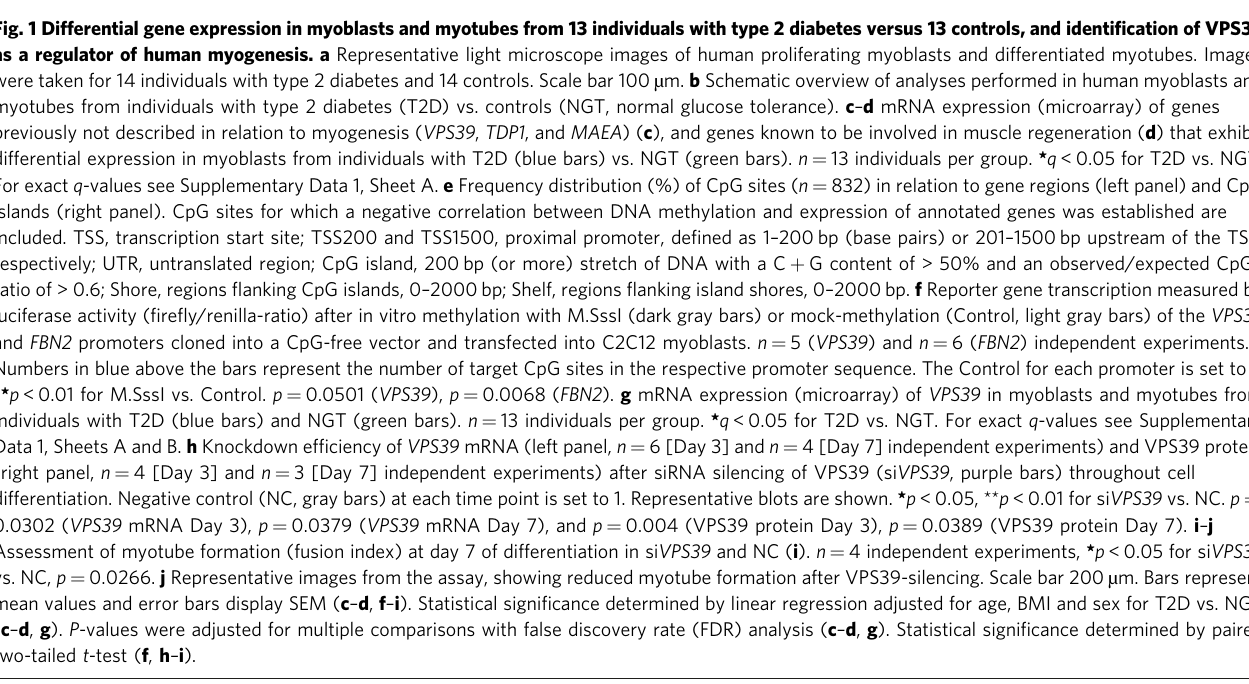
Fig. 1 Differential gene expression in myoblasts and myotubes from 13 individuals with type 2 diabetes versus 13 controls, and identi fi cation of VPS39 as a regulator of human myogenesis. a Representative light microscope images of human proliferating myoblasts and differentiated myotubes. Images were taken for 14 individuals with type 2 diabetes and 14 controls. Scale bar 100 µ m. b Schematic overview of analyses performed in human myoblasts and myotubes from individuals with type 2 diabetes (T2D) vs. controls (NGT, normal glucose tolerance). c – d mRNA expression (microarray) of genes previously not described in relation to myogenesis ( VPS39 , TDP1 , and MAEA ) ( c ), and genes known to be involved in muscle regeneration ( d ) that exhibit differential expression in myoblasts from individuals with T2D (blue bars) vs. NGT (green bars). n = 13 individuals per group. * q < 0.05 for T2D vs. NGT. For exact q -values see Supplementary Data 1, Sheet A. e Frequency distribution (%) of CpG sites ( n = 832) in relation to gene regions (left panel) and CpG islands (right panel). CpG sites for which a negative correlation between DNA methylation and expression of annotated genes was established are included. TSS, transcription start site; TSS200 and TSS1500, proximal promoter, de fi ned as 1 – 200 bp (base pairs) or 201 – 1500 bp upstream of the TSS, respectively; UTR, untranslated region; CpG island, 200 bp (or more) stretch of DNA with a C + G content of > 50% and an observed/expected CpG ratio of > 0.6; Shore, regions fl anking CpG islands, 0 – 2000 bp; Shelf, regions fl anking island shores, 0 – 2000bp. f Reporter gene transcription measured by luciferase activity ( fi re fl y/renilla-ratio) after in vitro methylation with M.SssI (dark gray bars) or mock-methylation (Control, light gray bars) of the VPS39 and FBN2 promoters cloned into a CpG-free vector and transfected into C2C12 myoblasts. n = 5 ( VPS39 ) and n = 6 ( FBN2 ) independent experiments. Numbers in blue above the bars represent the number of target CpG sites in the respective promoter sequence. The Control for each promoter is set to 1. * * p < 0.01 for M.SssI vs. Control. p = 0.0501 ( VPS39 ), p = 0.0068 ( FBN2 ). g mRNA expression (microarray) of VPS39 in myoblasts and myotubes from individuals with T2D (blue bars) and NGT (green bars). n = 13 individuals per group. * q < 0.05 for T2D vs. NGT. For exact q -values see Supplementary Data 1, Sheets A and B. h Knockdown ef fi ciency of VPS39 mRNA (left panel, n = 6 [Day 3] and n = 4 [Day 7] independent experiments) and VPS39 protein (right panel, n = 4 [Day 3] and n = 3 [Day 7] independent experiments) after siRNA silencing of VPS39 (si VPS39 , purple bars) throughout cell differentiation. Negative control (NC, gray bars) at each time point is set to 1. Representative blots are shown. * p < 0.05, ** p < 0.01 for si VPS39 vs. NC. p = 0.0302 ( VPS39 mRNA Day 3), p = 0.0379 ( VPS39 mRNA Day 7), and p = 0.004 (VPS39 protein Day 3), p = 0.0389 (VPS39 protein Day 7). i – j Assessment of myotube formation (fusion index) at day 7 of differentiation in si VPS39 and NC ( i ). n = 4 independent experiments, * p < 0.05 for si VPS39 vs. NC, p = 0.0266. j Representative images from the assay, showing reduced myotube formation after VPS39-silencing. Scale bar 200 µ m. Bars represent mean values and error bars display SEM ( c – d , f – i ). Statistical signi fi cance determined by linear regression adjusted for age, BMI and sex for T2D vs. NGT ( c – d , g ). P -values were adjusted for multiple comparisons with false discovery rate (FDR) analysis ( c – d , g ). Statistical signi fi cance determined by paired two-tailed t -test ( f , h – i